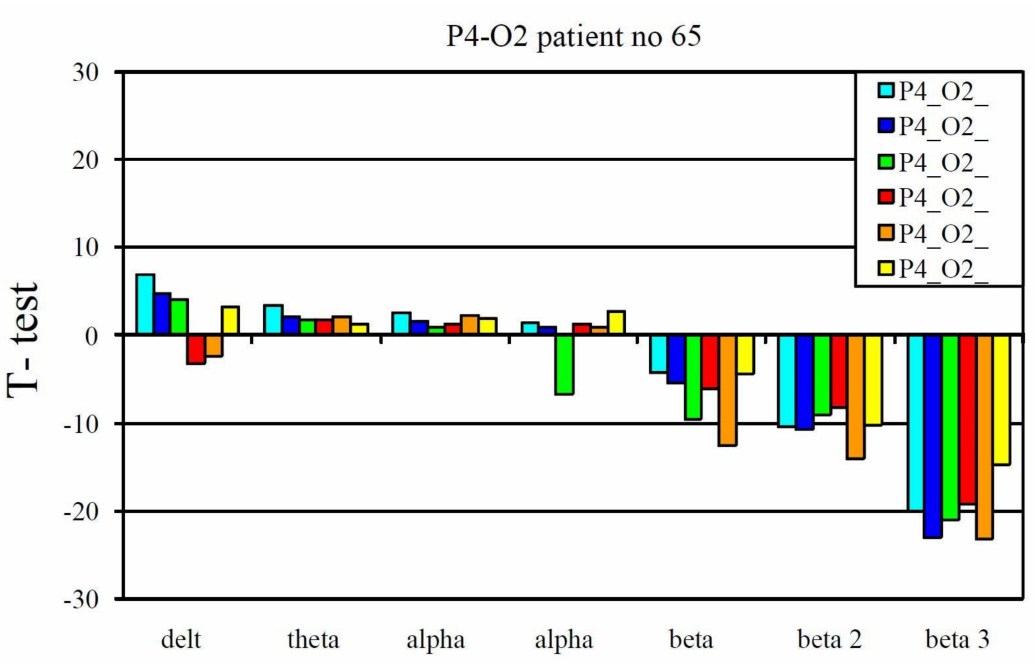
Figure 4. Example of a negative pharmaco-EEG profile during selective serotonin reuptake inhibitor treatment. Patient No. 65, who received fluoxetine, is an example of a patient with a